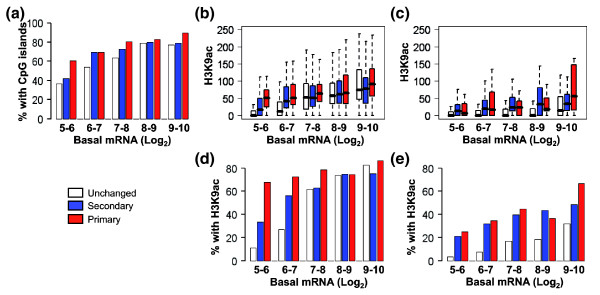
Higher H3K9ac on inducible genes is independent of the presence of CpG islands. (a) The percentage of genes with CpG islands is plotted for genes grouped by their kinetics of expression (red, primary response genes; blue, secondary response genes; white, unchanged genes) and basal expression levels (Log2 robust multichip average values from the expression microarrays). (b, c) H3K9ac MAT scores were plotted for the different gene groups subdivided into genes with (b) or without (c) CpG islands. The bar marks the median score, the edges of the boxes the second and third interquartile ranges and the whiskers the first and fourth interquartile ranges. (d, e) The percentage of promoters with a H3K9ac MAT score >35.2 (FDR <5%) was plotted for the different groups subdivided into genes with (d) or without (e) CpG islands.